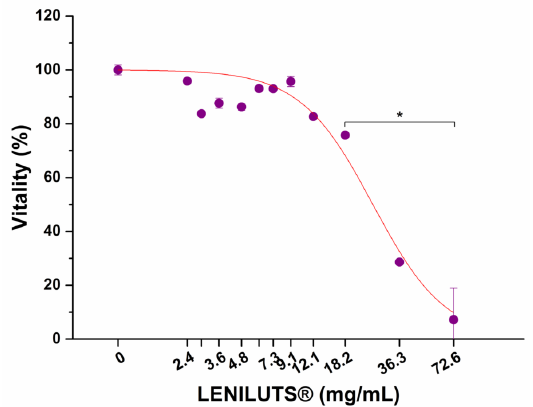
Figure 6. Impact of increasing concentration of digested LENILUTS ® on intestinal mucosa viability evaluated by MTS assay. * p < 0.05.